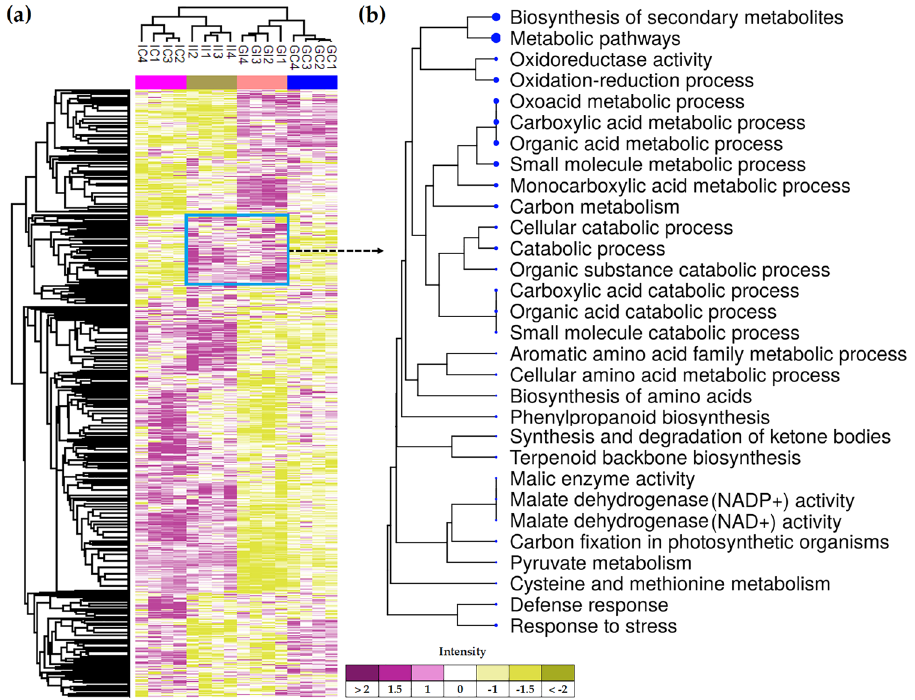
Figure 5. ( a ) The Z-scored (normalized) abundance of the complete set of identified proteins. GI, Gladiator infected; GC, Gladiator control; II, Iwa infected; IC, Iwa control. ( b ) A hierarchical clustering tree summarizing the correlation among significant pathways of the increased DAPs common between Gladiator and Iwa. Pathways with several shared genes are clustered together. Bigger dots (blue dots) indicate more significant P